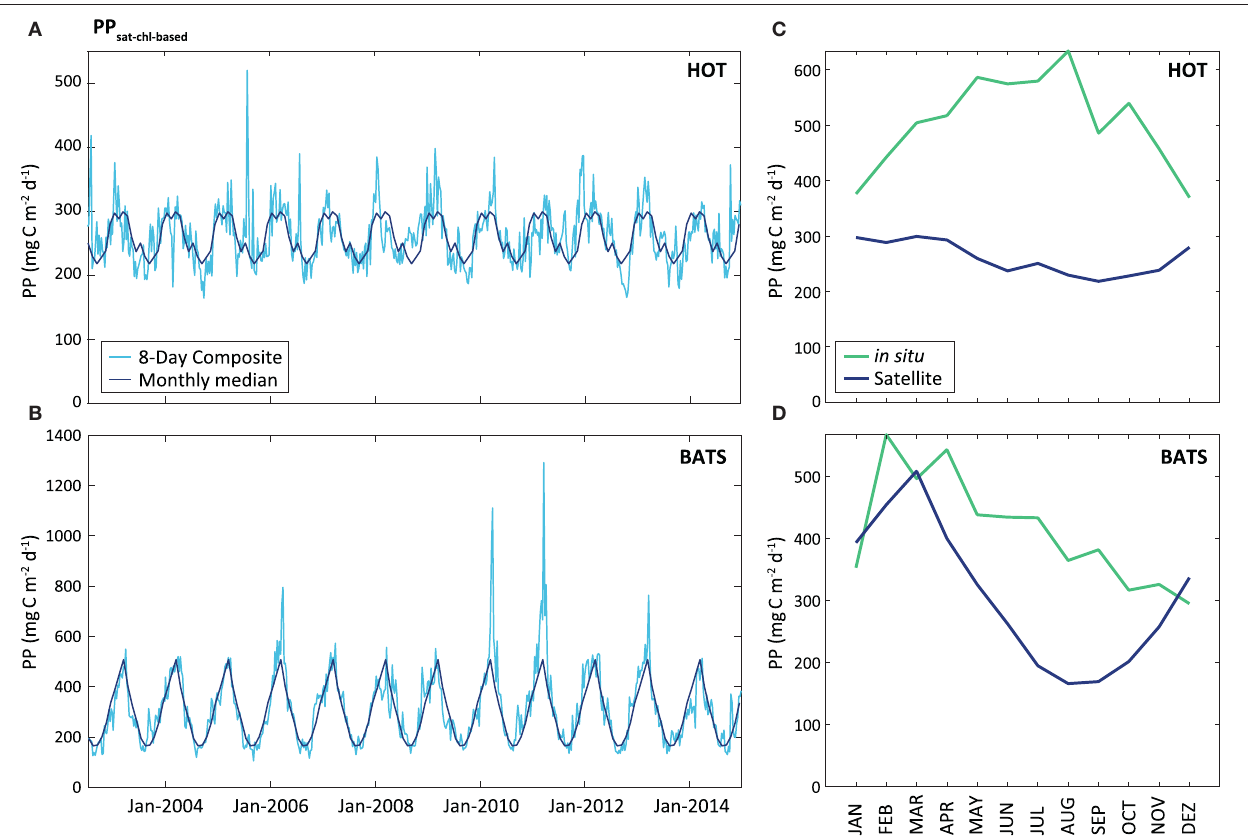
FIGURE 7 | PP sat (expressed in mg C m − 2 d − 1 ) obtained through the VGPM model, Chl-based. The light blue line represents the results obtained for the 8-Day composite, while the dark blue represents the monthly median calculated for these data, at HOT (A) and BATS (B) . The graphs on the right shows a comparison between satellite and in situ PP estimates (monthly median of the PP sat − chl − based in the blue line, and monthly median of the PP in situ in the green line), for HOT (C) and BATS (D) .